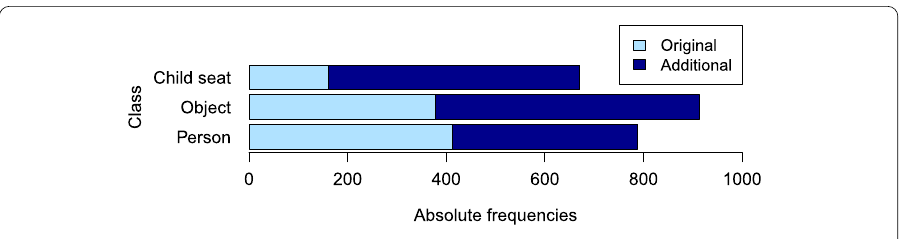
Figure 6 Distribution of the classes over the 1100 images of the training set. By “Original” the set of the first 500 images is described. “Additional” describes the set of the 600 images by which the training set was